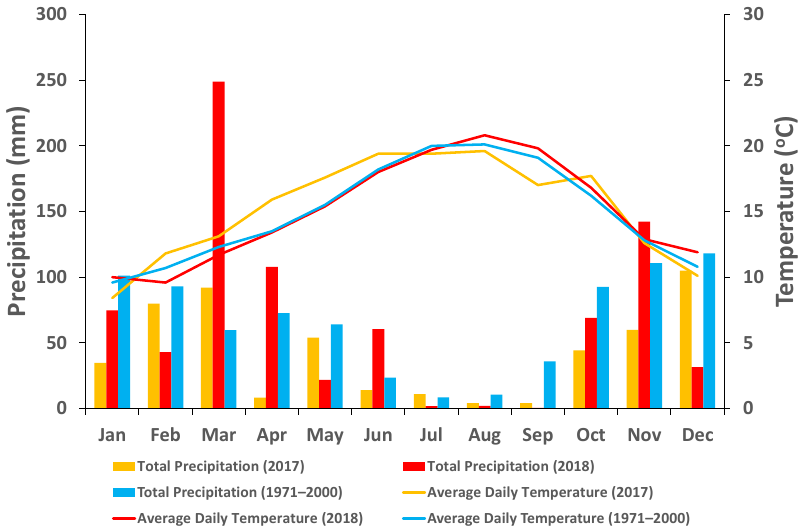
Figure 2. Average daily temperature and monthly precipitation in the meteorological station of Monte Real (Leiria, Portugal) for the periods 1971–2000, 2017 and 2018 [41,42].